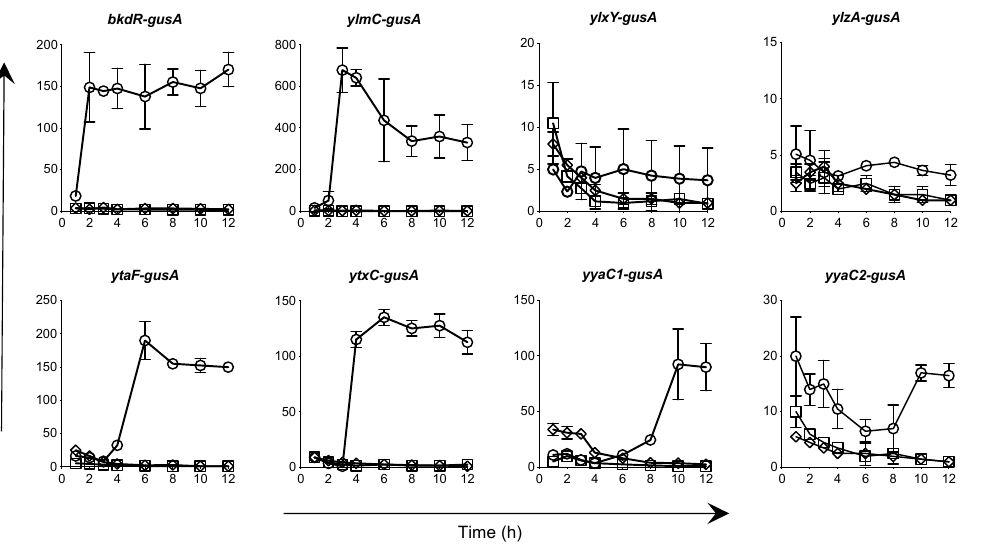
ytaF , ytxC , yyaC1 and yyaC2 are sporulation-regulated genes and are dependent on ex- pressions of spo0A and sigE .